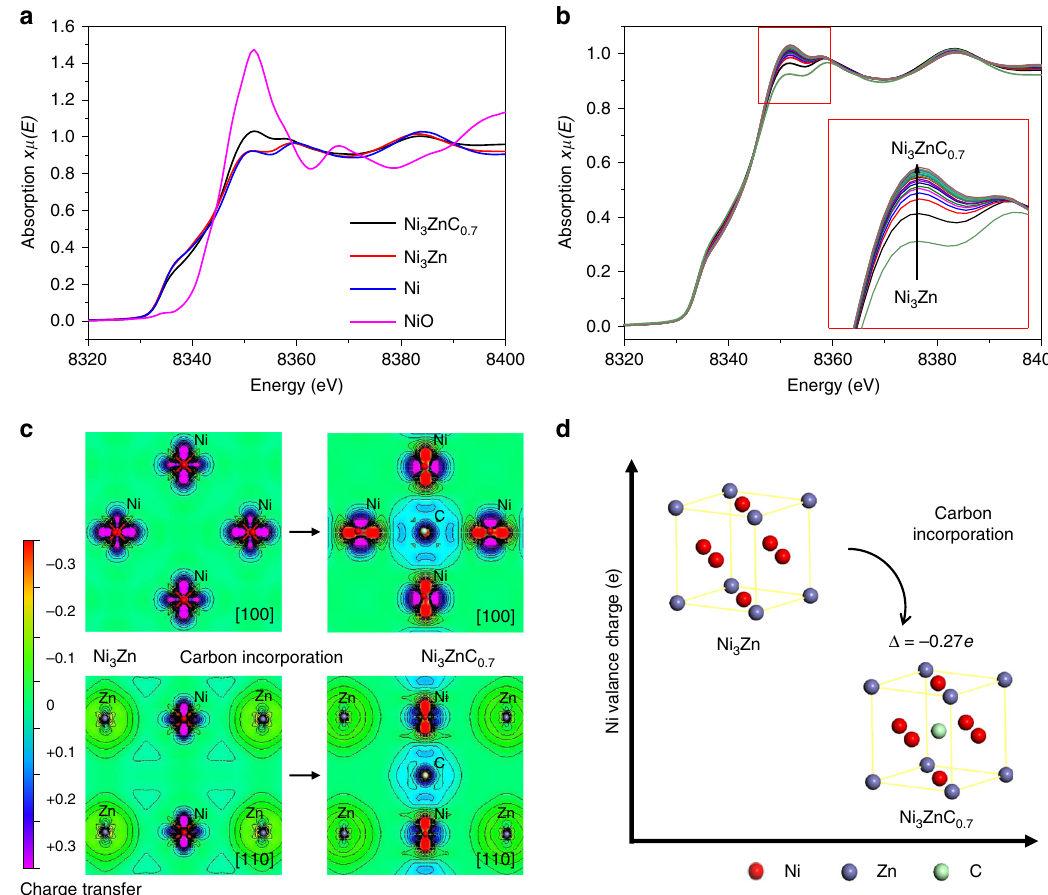
Fig. 4 Electronic structure of Ni in Ni 3 Zn and Ni 3 ZnC 0.7 . a Normalized Ni K-edge XANES spectra of NiO (pink curve), Ni foil (blue curve), Ni 3 Zn (red curve), and Ni 3 ZnC 0.7 (black curve), respectively. b In situ Ni K-edge XANES spectra during the process from Ni 3 Zn to Ni 3 ZnC 0.7 under 1.0 vol% C 2 H 2 /He atmosphere at 200 °C. c Charge density difference plots of the interface along [100] and [110] directions of Ni 3 Zn and Ni 3 ZnC 0.7 . d The charge density variation of Ni when transformed from Ni 3 Zn to Ni 3 ZnC 0.7 . Δ represents that the introduction of C to Ni 3 Zn renders Ni with an electron de fi ciency of − 0.27 per